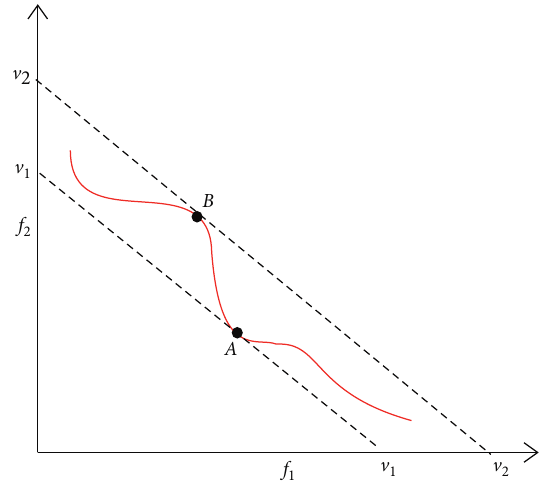
Figure 2: Illustration of the MMD